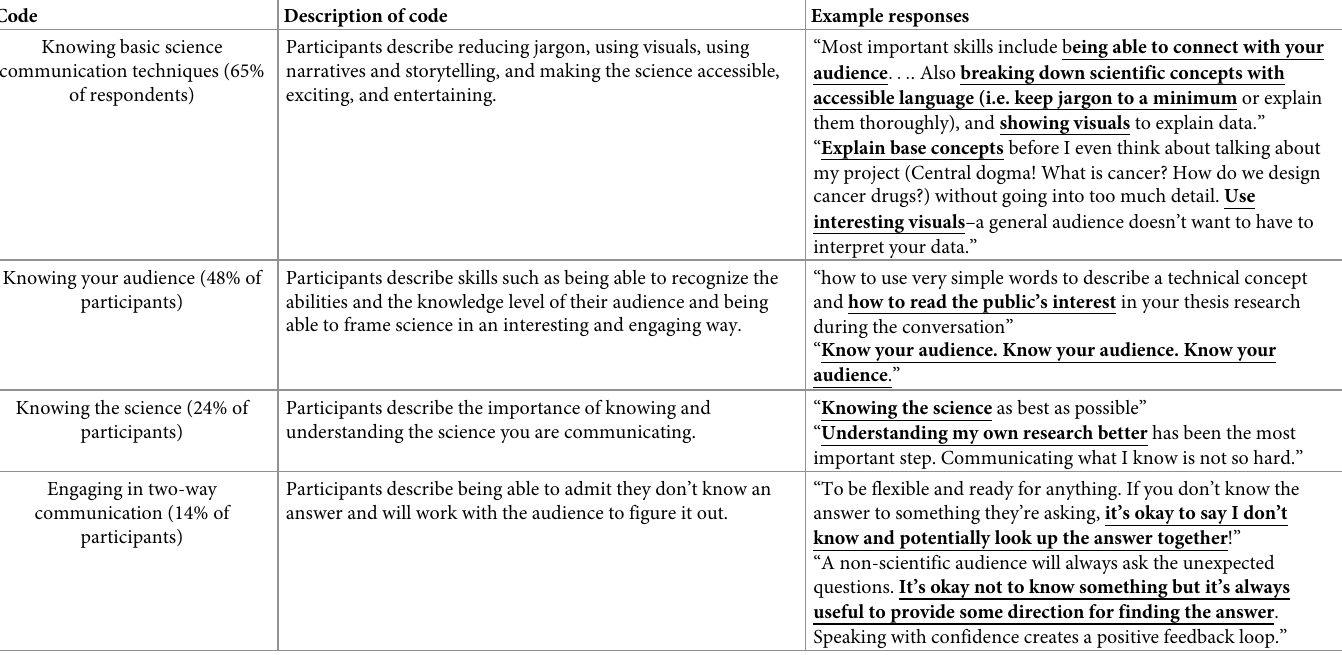
Table 8. For participants who have communicated their thesis to the general public we asked: “what skills did you need?” the resulting codes are shown in the left hand column, with a description of each code in the center column, and example responses from participants in the right hand column. Text from each response that is directly relevant to each code is in bold and underlined